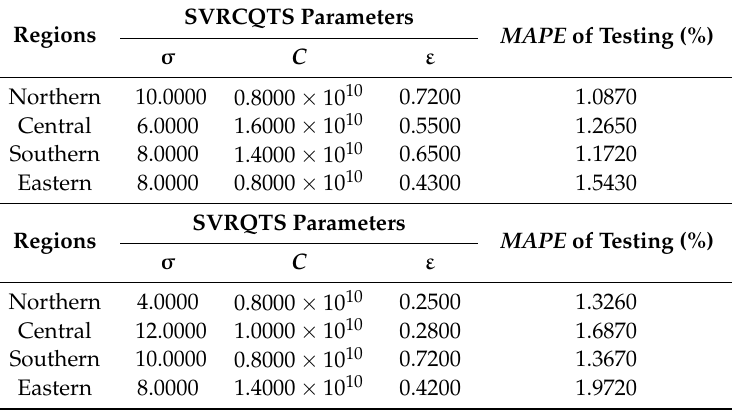
Table 1. Parameters determination of SVRCQTS and SVRQTS models (example 1).